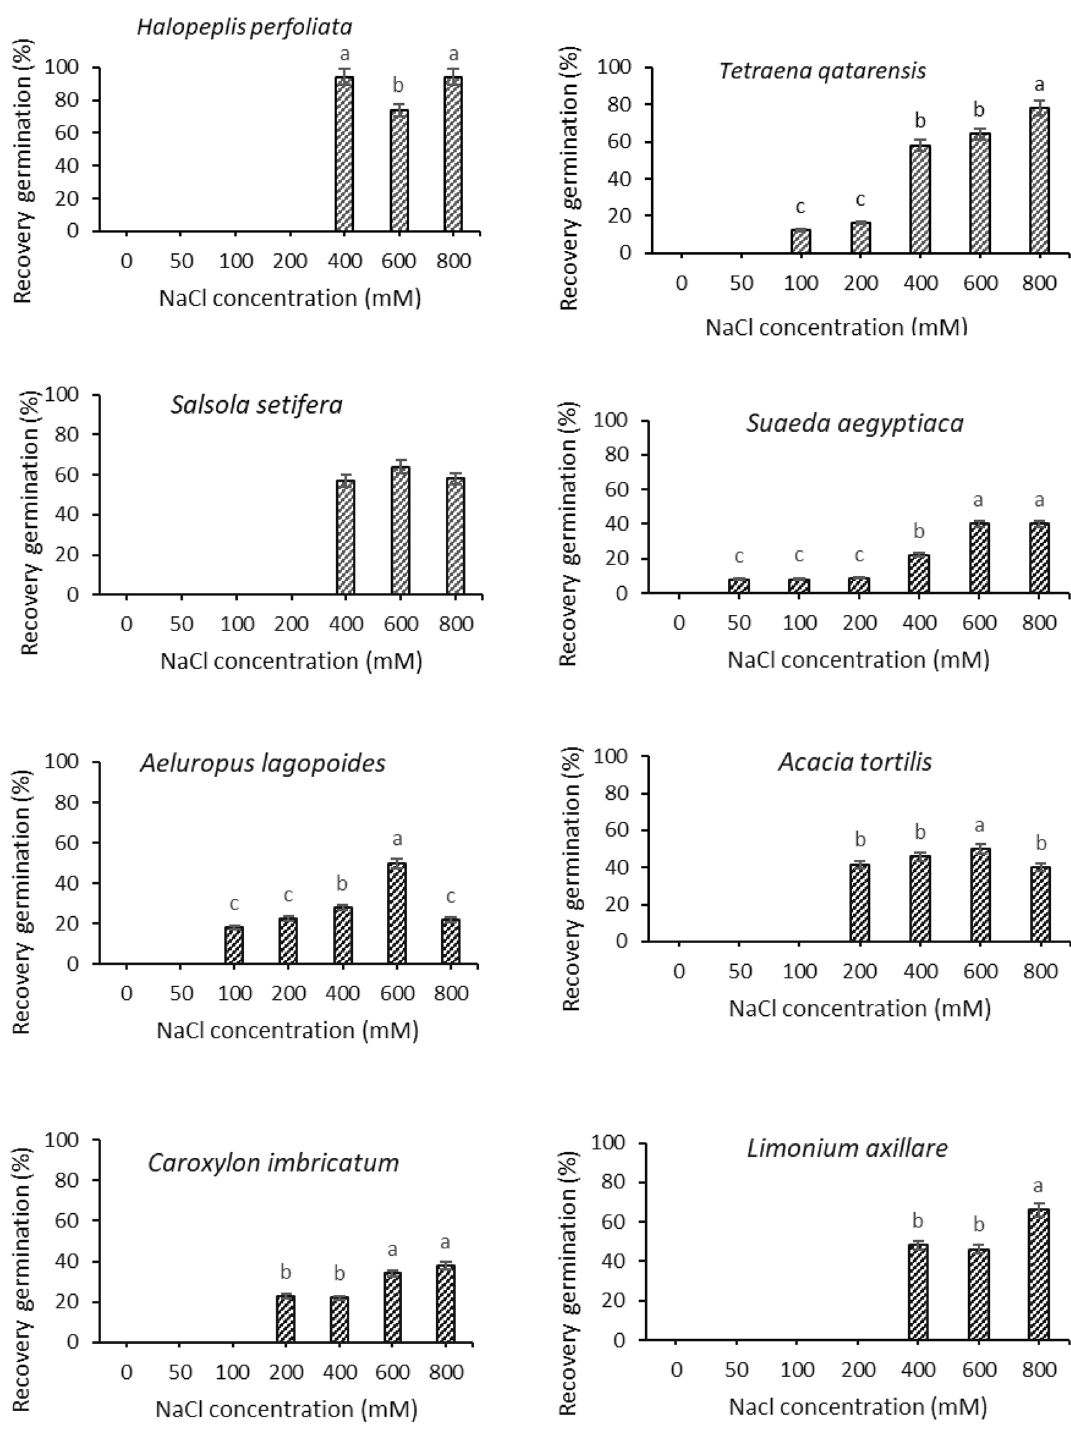
Figure 3. Percentage of seeds that able to recover germination when subjected to distilled water after three weeks of NaCl treatments. Values shown are means ± S.E. Values in a figure with a common letter are not significantly different according to Tukey’s test at p ≤ 0.05. The absence of letters in a graph means no significance among more than 250 mM NaCl, among those Salicornia brachystachya 38 . Moreover, many halophytes can tolerate salt on their mature plant form, but their seeds still failed to germinate on concentration of above 300 mM NaCl 39 . Similar to what obtained by 32,40,41 , seeds of Halopeplis perfoliata were not dormant and ready to germinate at the control treatment (Fig. 2). In the present study, H. perfoliata seeds achieved similar germination in distilled water, but failed to germinate at higher treatments (e.g. 400 mM). Similar to our results, in Saudi Arabia, the